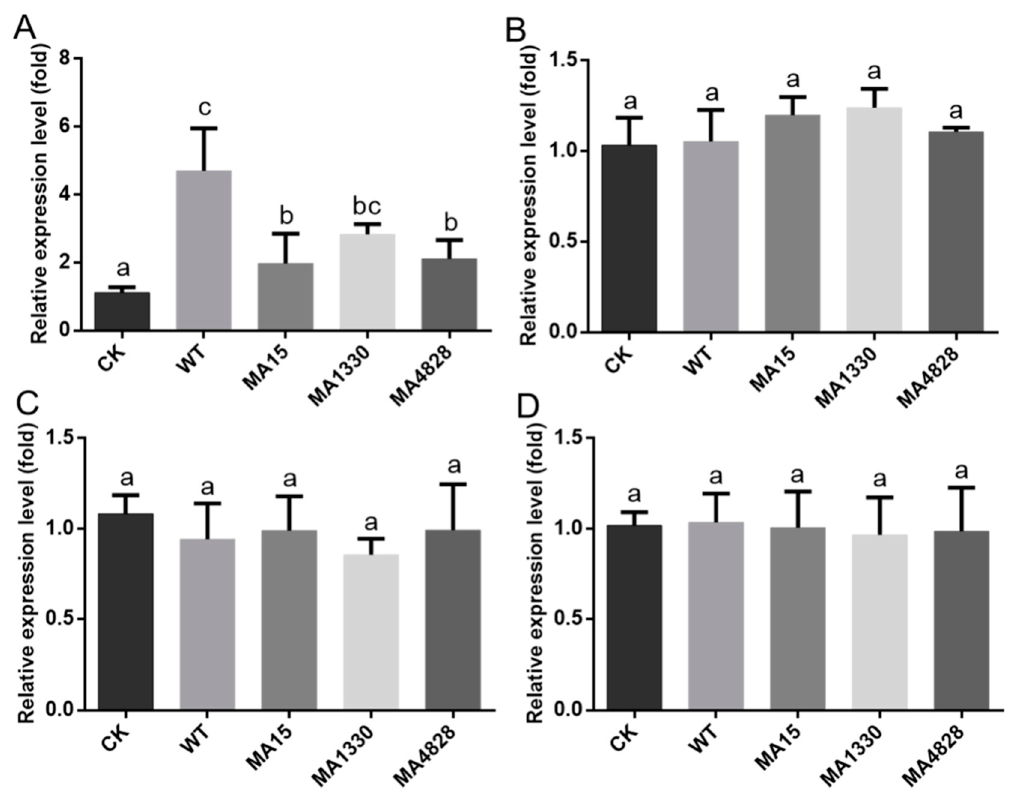
Figure 6. Transcription levels of defense-related genes in P. massoniana seedlings in response to WT or mutant inoculation. The related expression levels of PR2 ( A ), PAL ( B ), COI ( C ), and GPX ( D ) in seedlings 4 days after WT or mutant inoculation. Experiments were performed in triplicate with three biological replicates. Different letters above the bars indicate significant differences ( p < 0.05).